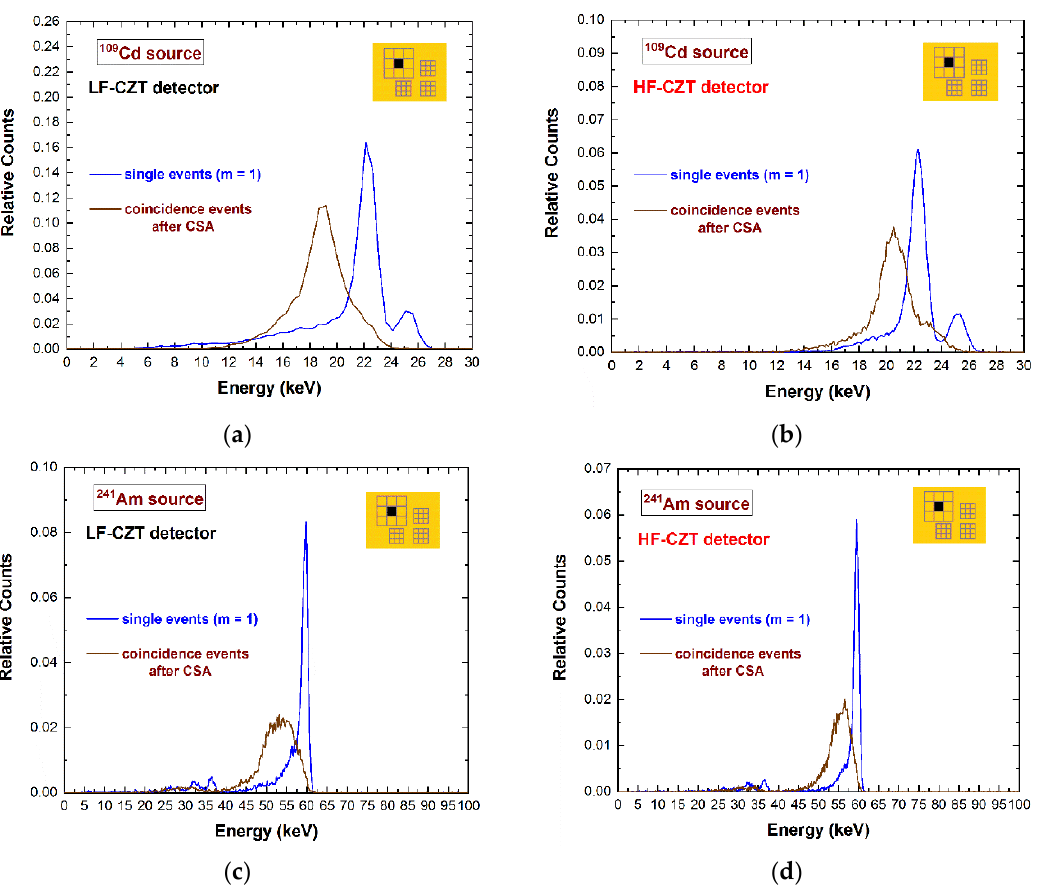
Figure 3. Comparison between the raw 241 Am energy spectrum (black line) and the spectrum (violet line) after charge-sharing discrimination (CSD). The energy spectra are related to the central pixel of the 500 μ m array of the HF-CZT detector. After CSD, 56% of all events are rejected.